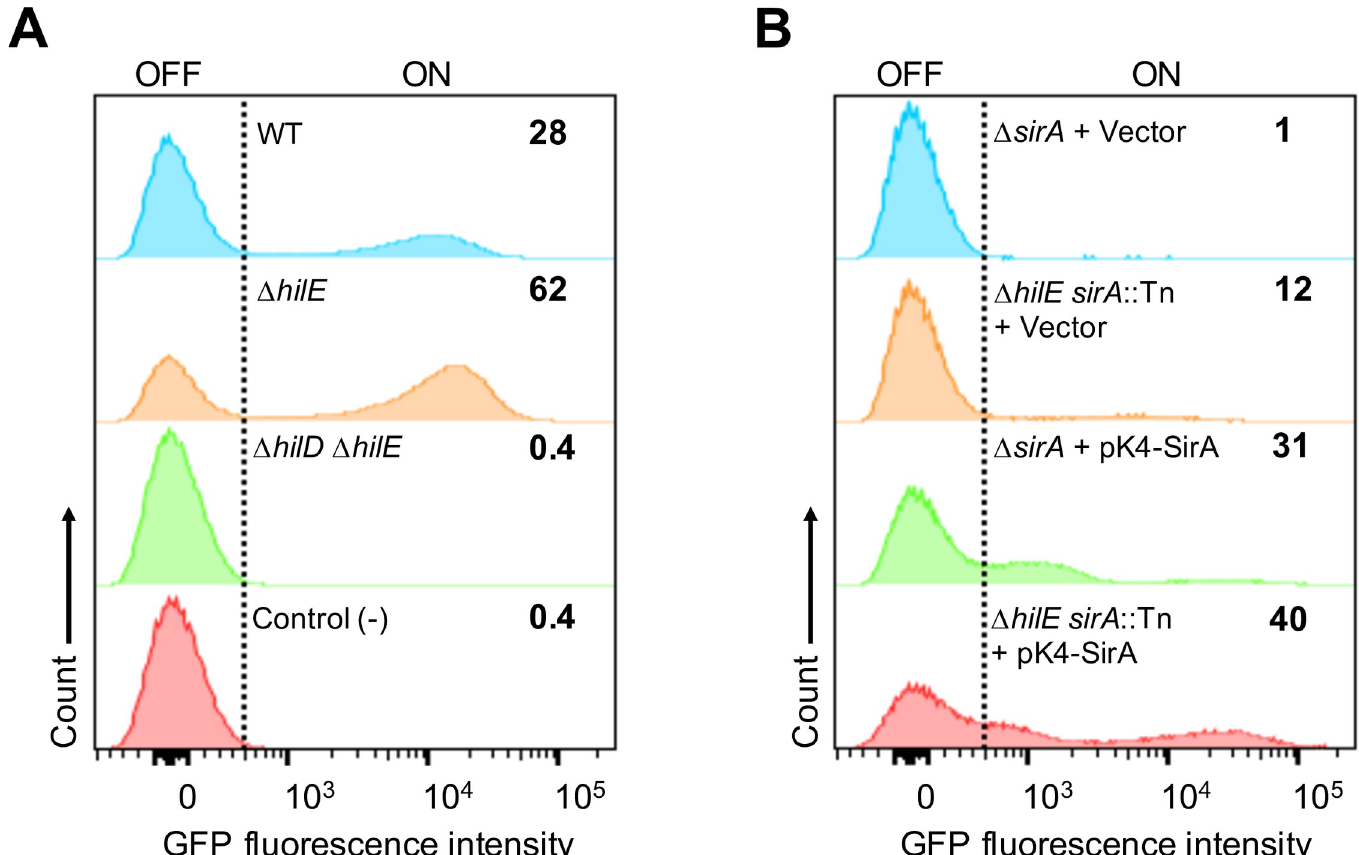
Fig 5. HilE negatively controls the bistable expression of SPI-1. Flow cytometry analysis of GFP fluorescence expression of the invF-gfp transcriptional fusion contained in the low copy pMPMA3 Δ Plac P invF - gfp [LVA]/Rplasmid in different S . Typhimurium strains. (A) GFP expression in cultures of the WT strain and its derivative Δ hilE and Δ hilE Δ hilD mutants carrying the invF-gfp fusion, as well as in cultures of the WT strain carrying the gfp reporter gene without a promoter (negative control). (B) GFP expression in cultures of the sirA ::Tn 10 d and Δ hilE sirA ::Tn 10 d mutants carrying the invF-gfp fusion and the pMPM-K4 O vector or the pK4-SirA plasmid expressing SirA. The percentage of the GFP+ population of each strain is indicated on the graphs. Data shown are representative of two independent experiments performed with ten independent bacterial colonies.